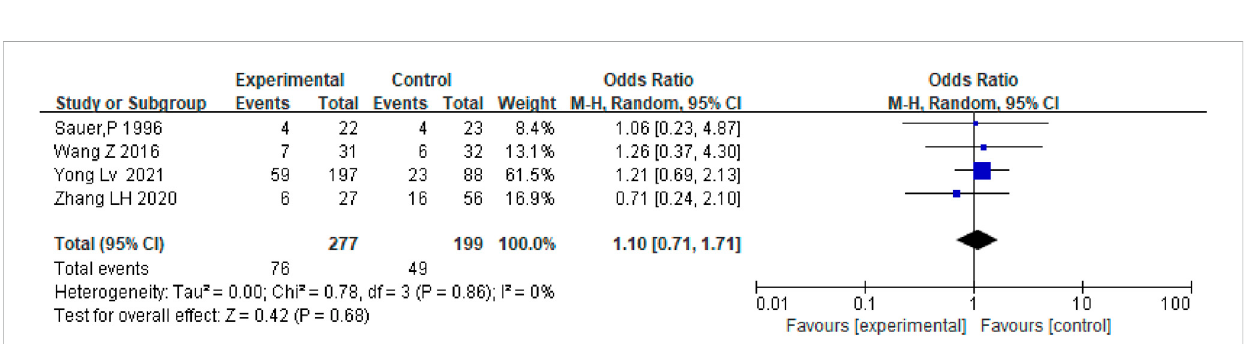
FIGURE 10 Effect of anticoagulation or antiplatelet treatment on hepatic encephalopathy after TIPS.